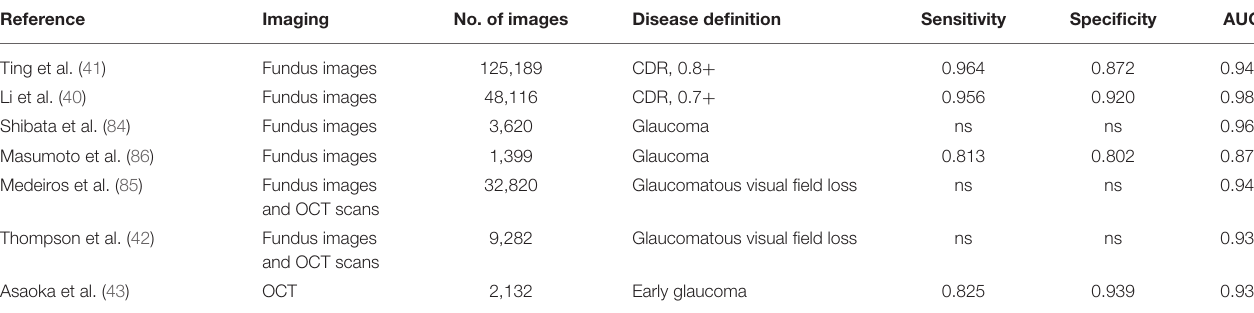
TABLE 1 | Summary of studies on AI and